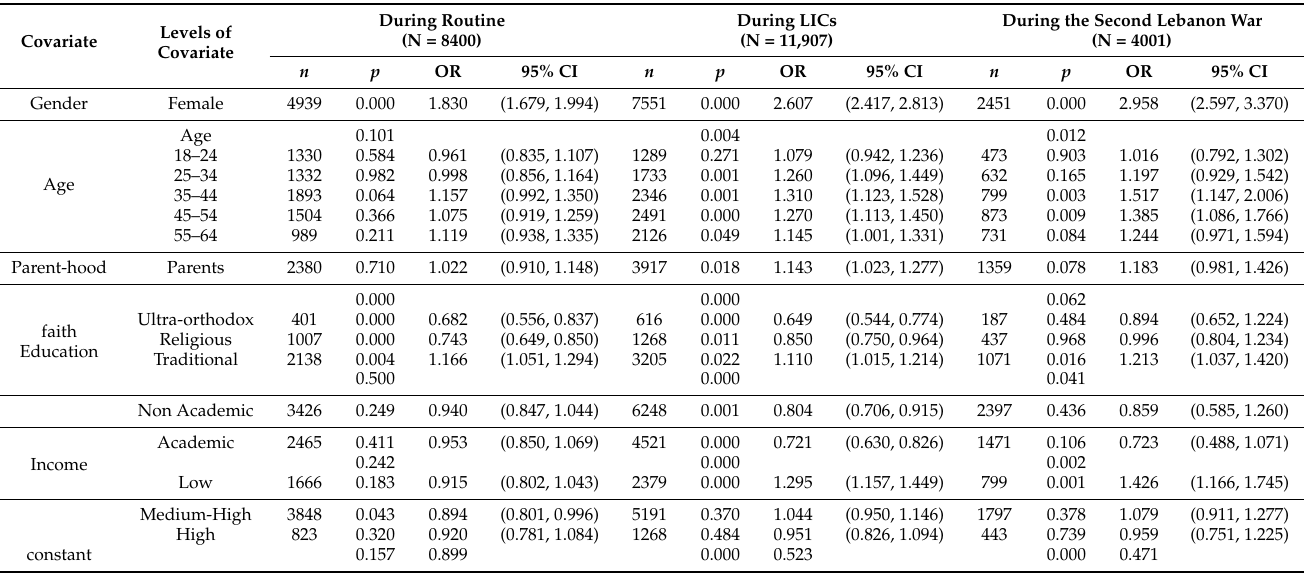
Table 6. Binary logistic model predicting “fear of the future” during LICs and during routine, stratified